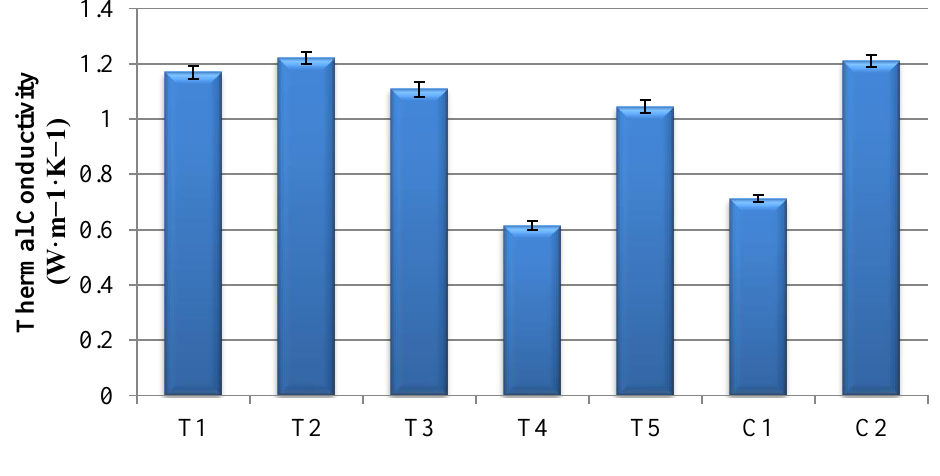
Figure 9. Thermal Conductivity